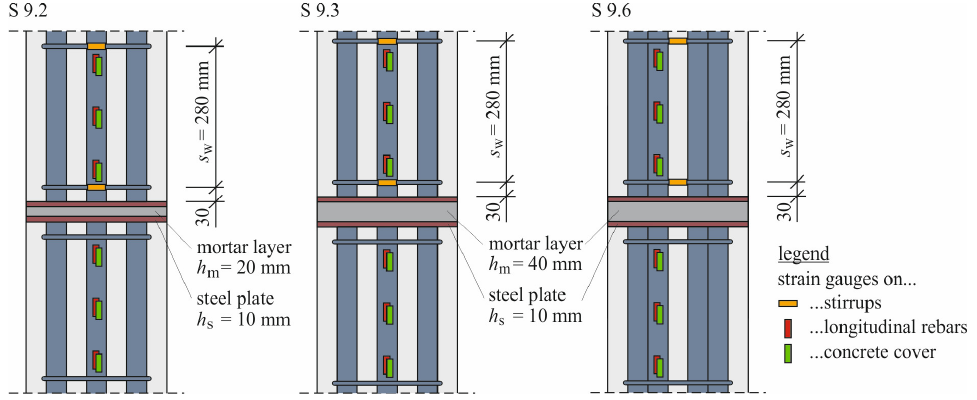
Figure 3. Configurations of the test specimens S 9.2, S 9.3 and S 9.6.